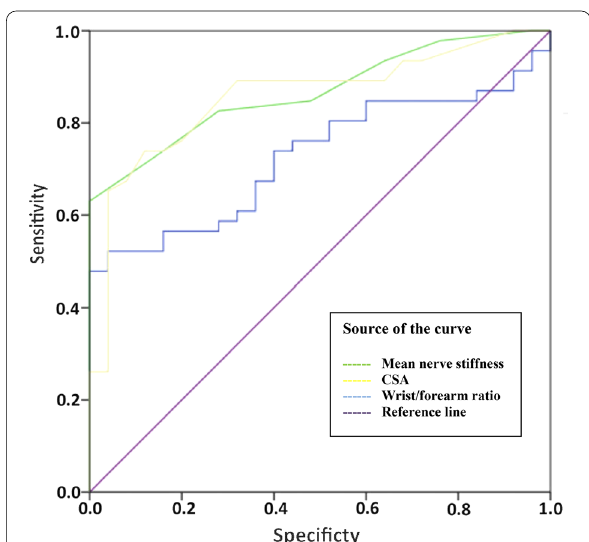
Fig. 7 A Receiver operating characteristic curve analysis showed optimal cutoff value for mean stiffness value of median nerve, CSA and wrist/forearm ratio. Green line for mean median nerve stiffness, yellow line for CSA, blue line for wrist/forearm ratio